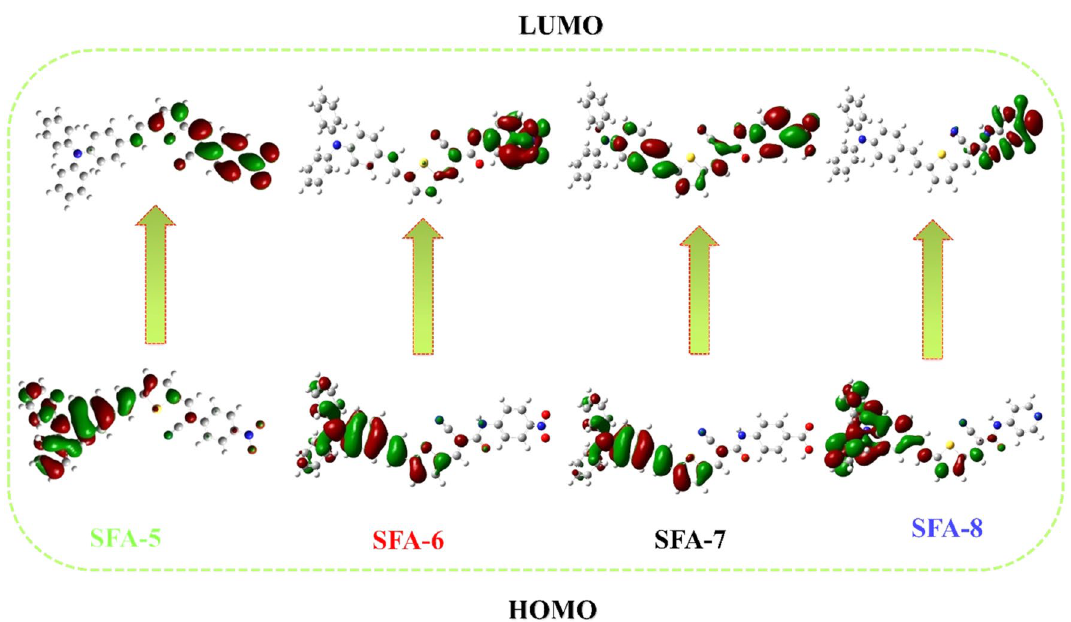
Figure 8. Optimized geometry structures for SFA-5–8